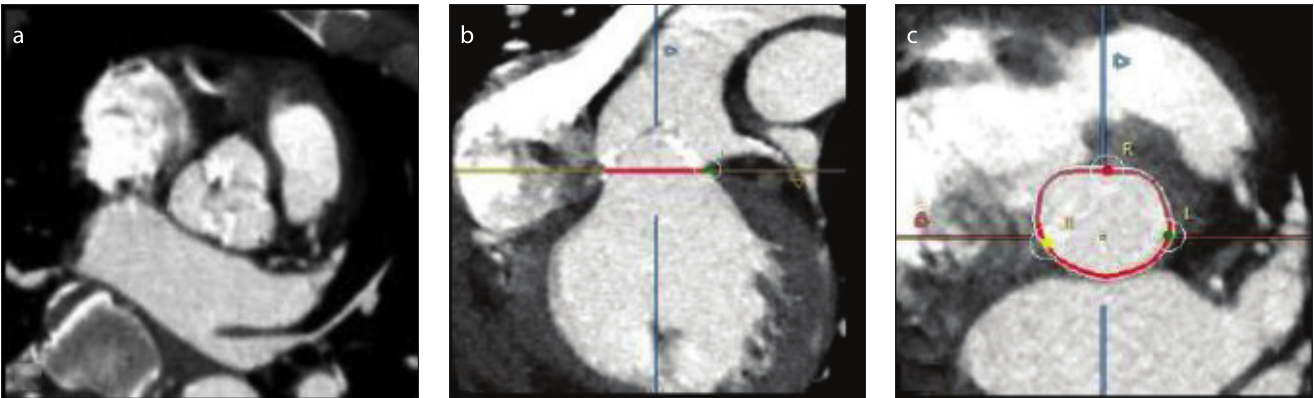
Figure 3. a, b. a) Edwards valve sizing chart. Courtesy of Edwards Lifesciences Cooperation, Irvine, CA. b) CoreValve sizing chart. Courtesy of Edwards Lifesciences Cooperation, Irvine, CA.